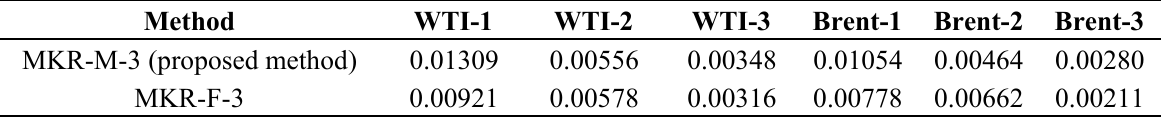
Table 12. Average APP results for WTI and Brent crude oil price prediction (14 experiments in